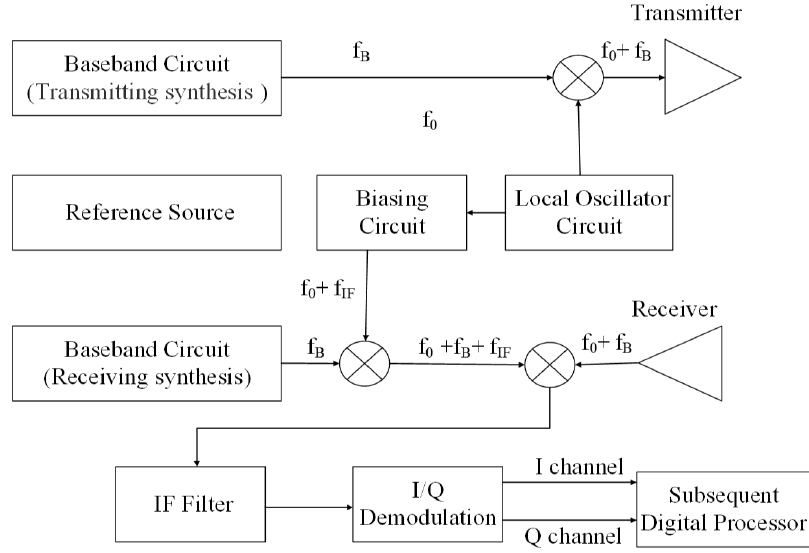
Figure 1. The schematic diagram of SFCW radar.